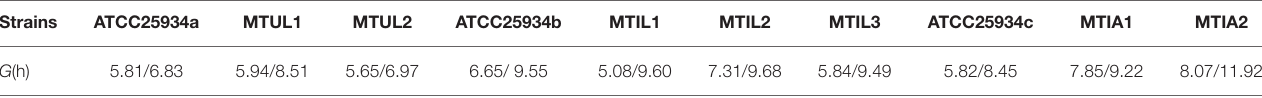
TABLE 4 | Growth kinetic parameters of drug resistant strains and parental ATCC 25934. Strains ATCC25934a MTUL1 MTUL2 ATCC25934b MTIL1 MTIL2 MTIL3 ATCC25934c MTIA1 MTIA2 G